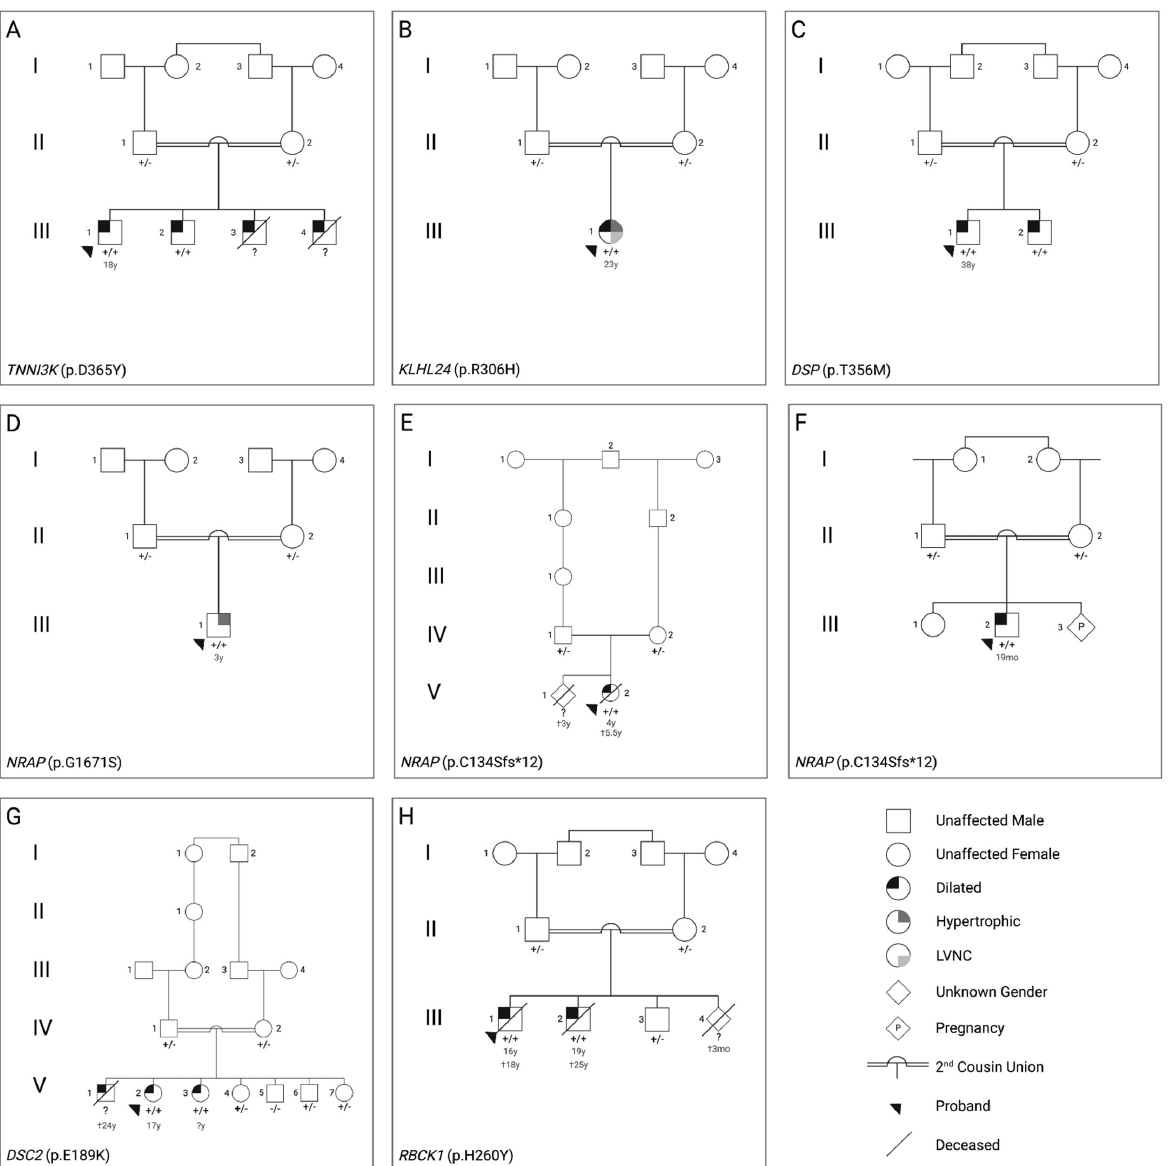
Figure 1. Pedigrees and candidate causal variants for the eight consanguineous cardiomyopathy families (( A – H )—see clinical characteristics/genetic findings) investigated by whole exome sequencing. Candidate gene and variant are shown for each family in the bottom left corner of each pedigree and +/ − denotes genotype results from Sanger Sequencing. LVNC = Left ventricular non com- paction, Dilated = Dilated cardiomyopathy, Hypertrophic = Hypertrophic cardiomyopathy. Age at presentation of symptoms and age at death (†), where available, is shown below affected individu- als.